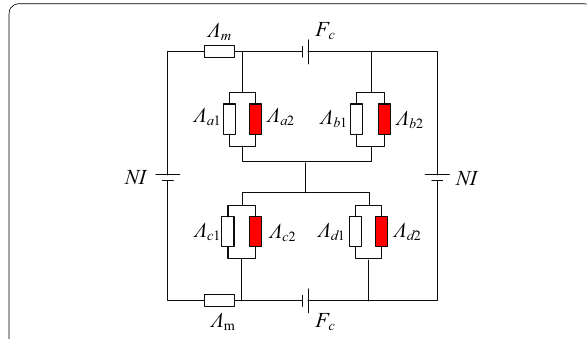
Figure 4 Equivalent magnetic circuit diagram of REMC-H